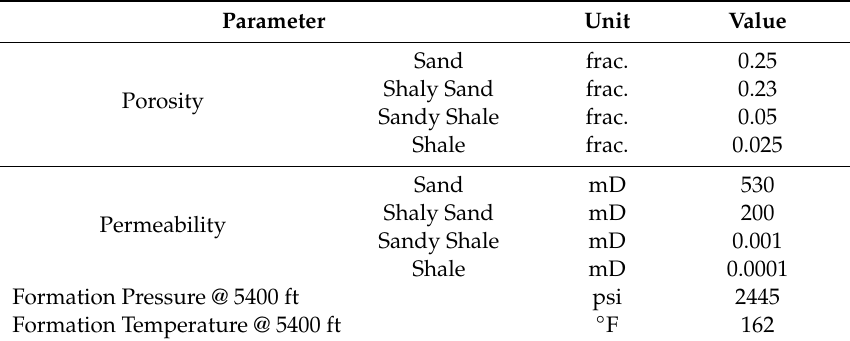
Table 1. Reservoir parameters and initial